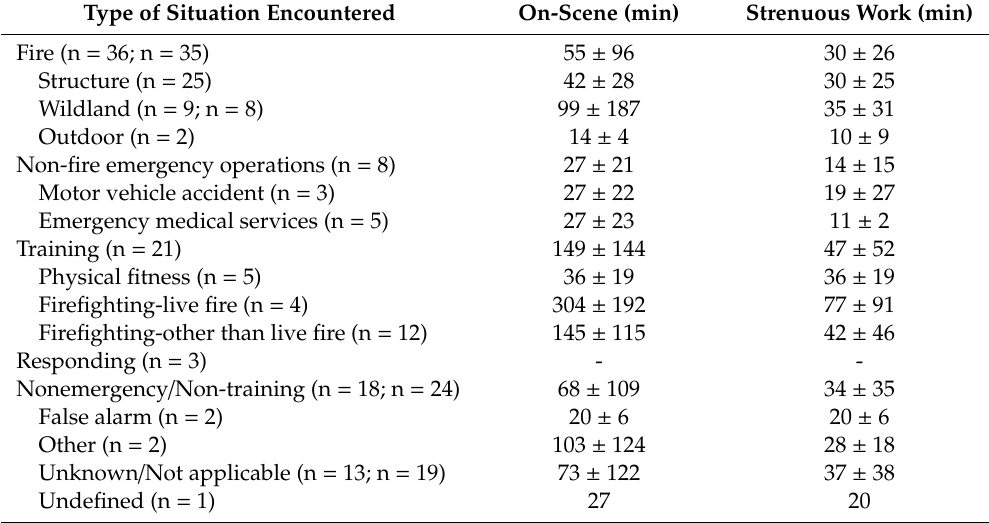
Table 4. Time (mean ± SD) spent on-scene and performing strenuous work prior to the onset of symptoms by type of situation encountered among cardiac fatalities investigated by NIOSH for incidents that occurred 9 January 2008–10 February 2017 (N = 92). Type of Situation Encountered On-Scene (min) Strenuous Work